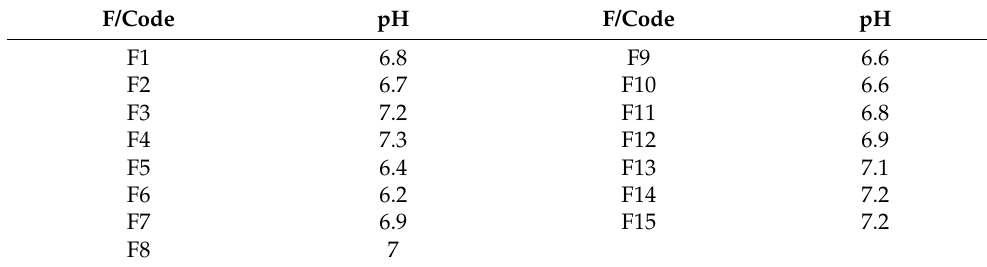
Table 11. pH of the 15 formulations of the